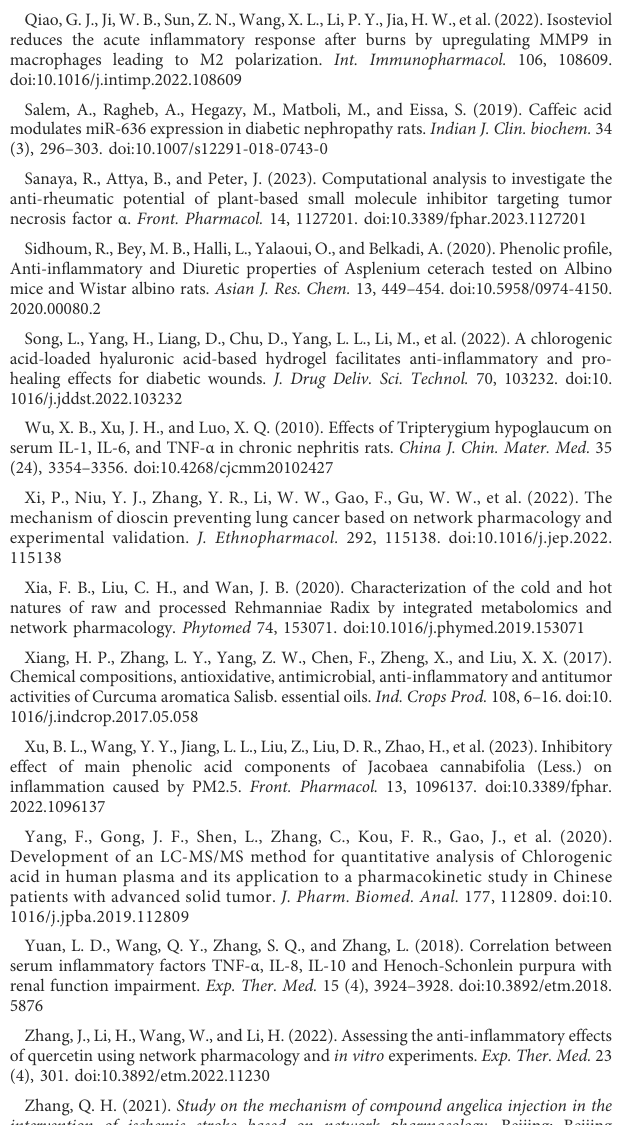
Nrf2 signaling pathway in A549 cells. Molecules 25 (6), 1385. doi:10.3390/